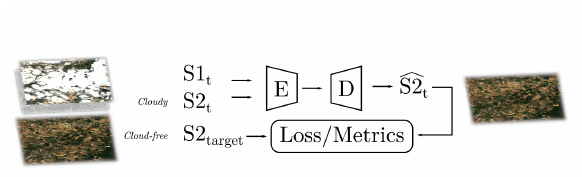
Figure 5. Our modified SSOP network. S 1 t and S 2 t denotes the input pair of Optical and SAR images. The S 2 t (cid:48) denotes the reference image used to compute the loss (during training) and the metrics (at inference time from test data) from the reconstructed optical image (cid:100) S 2 t . (E) and (D) denotes respectively the encoder and the decoder of the U-Net backbone.